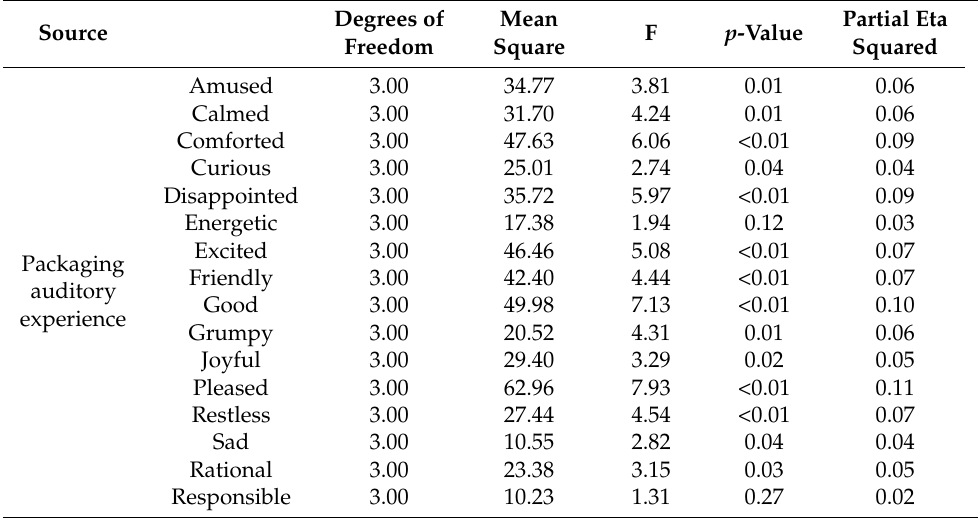
Table 2. Summary of the results of the univariate tests of Experiment 1 at the between-participants level (packaging auditory experience condition) on each emotion score. Source